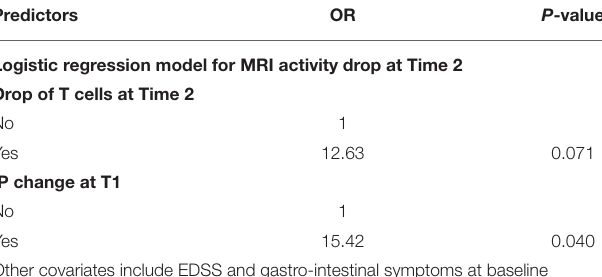
TABLE 2 | Probability of MRI activity reduction at T2 in cases with parallel drop of CD161 + CCR6 + CD8 + T cells in blood, and in cases with IP changes at T1. Predictors OR P -value Logistic regression model for MRI activity drop at Time 2 Drop of T cells at Time